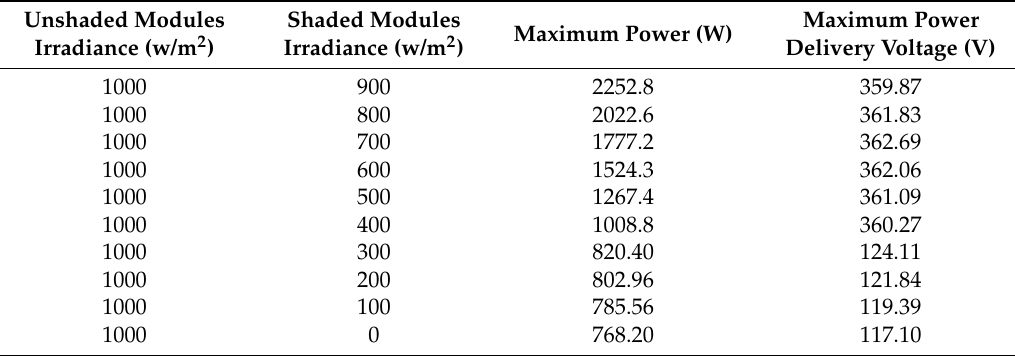
Table 8. Maximum powers of the 12 modules shaded